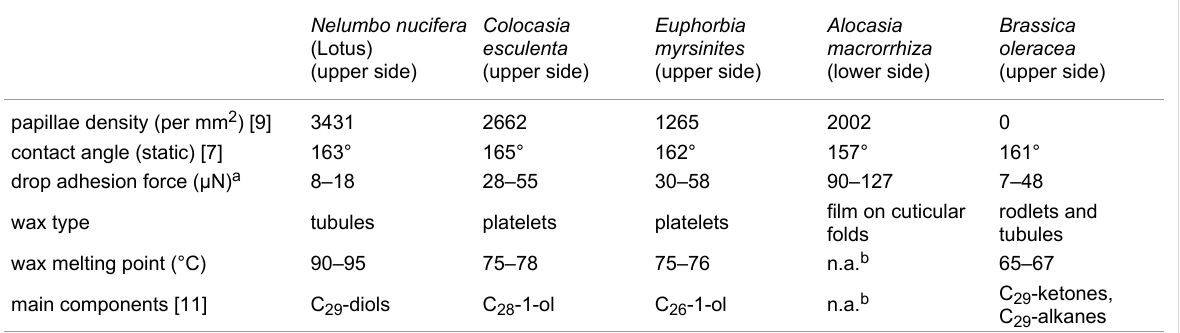
Table 1: Comparison of water repellency relevant properties of lotus and other selected species.